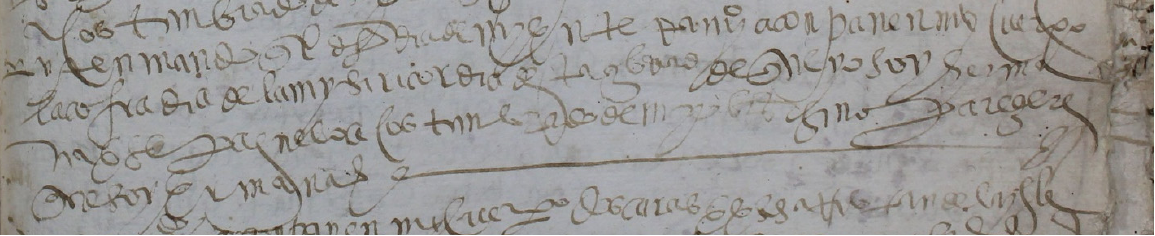
Figure 10. Detail from Isabel Muñoz’s will (April 1561). AHPC, PNSR 152, f. 100r. Reproduced with the permission of the Archivo Histórico Provincial de Cádiz [photo © Archivo Histórico Provincial de Cádiz (cropped from larger